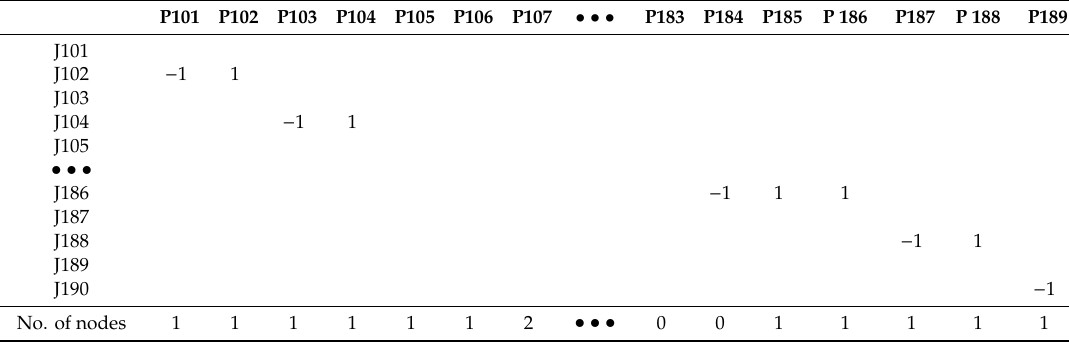
Table 4. Drain direction matrix for the CY water transmission